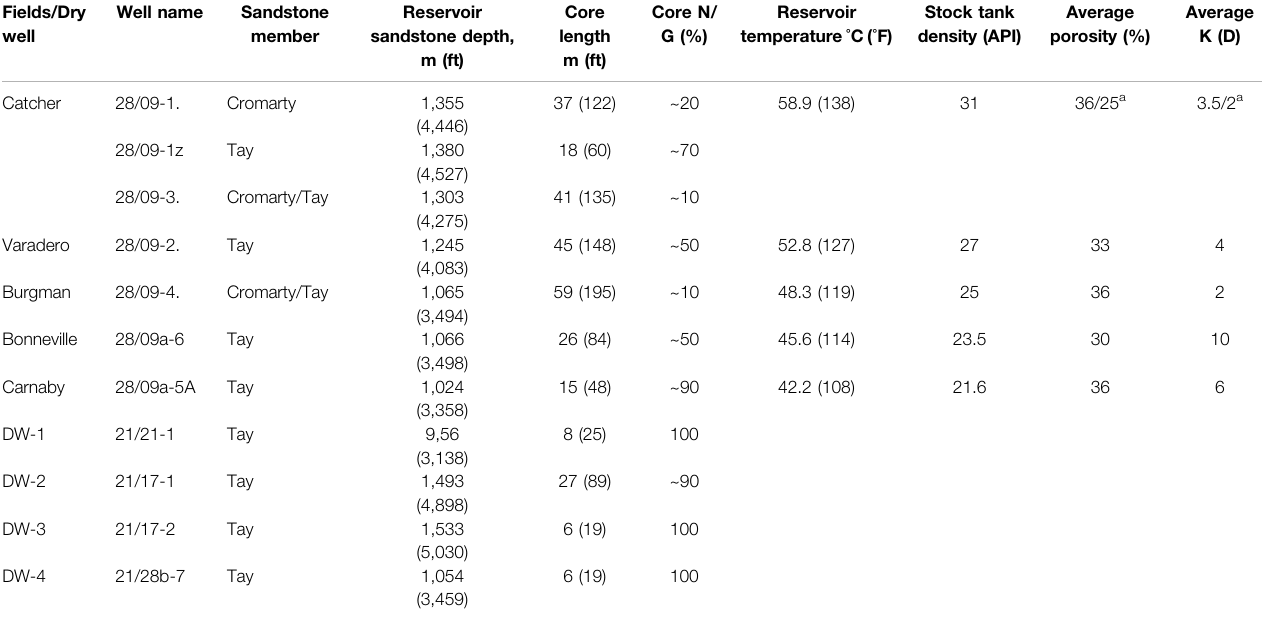
TABLE 1 | Reservoir and fl uid properties for Catcher Area Development (CAD) fi elds, compiled using details obtained from well reports (Available at https://ndr.ogauthority. co.uk). Fields/Dry